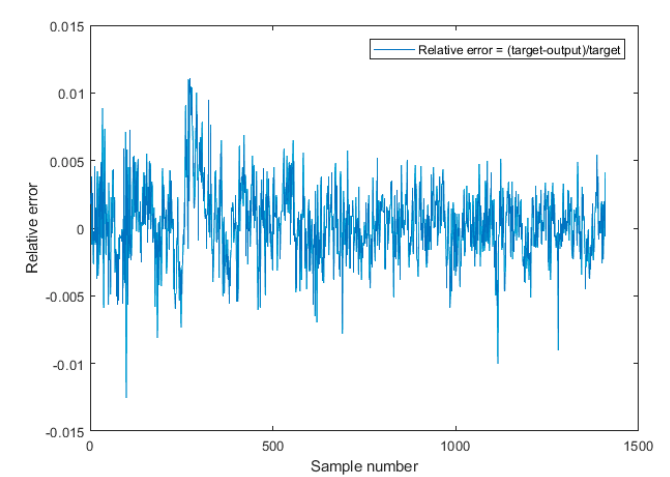
Figure 12. Relative error histograms with 50 bins obtained during the learning process for the best analyzed neural network.